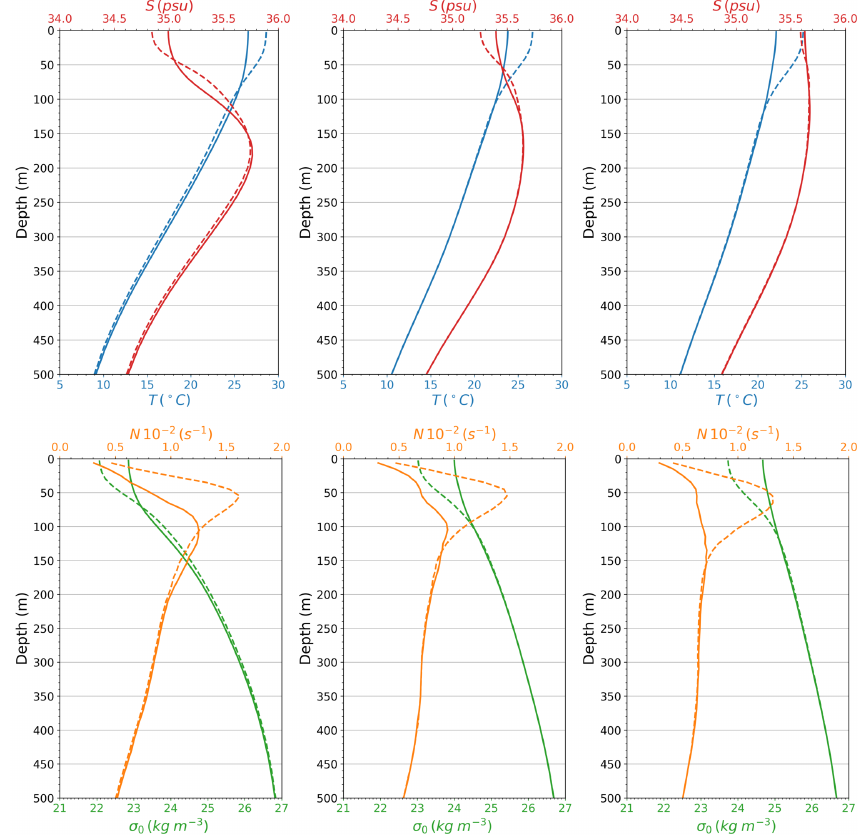
Figure 3. Mean seasonal profiles of temperature (blue), salinity (red), potential density σ 0 referenced to the surface pressure (green) and buoyancy frequency N 2 (orange), separated into a cool season (June to November, solid curves) and a warm season (December to May, dashed